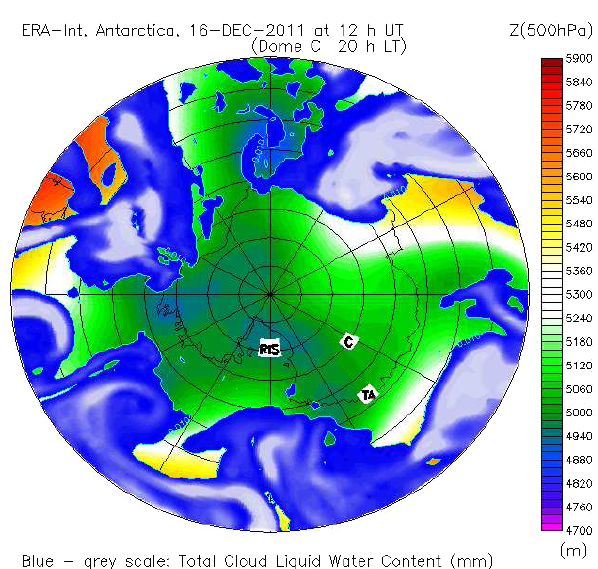
Figure 4. 500hPa geopotential (m) over Antarctica on 16 Decem- ber 2011 at 12:00UT (colour key to the right). Total cloud liquid water content (TCLW), from 0.01 (dark blue) to 1.2mm (grey), is also shown. The TCLW 0.01mm isocontour is also represented by a cyan line. Dome C is indicated by the letter “C”. Terre Adélie and the Ross Ice Shelf are indicated respectively by “TA” and “RIS”.